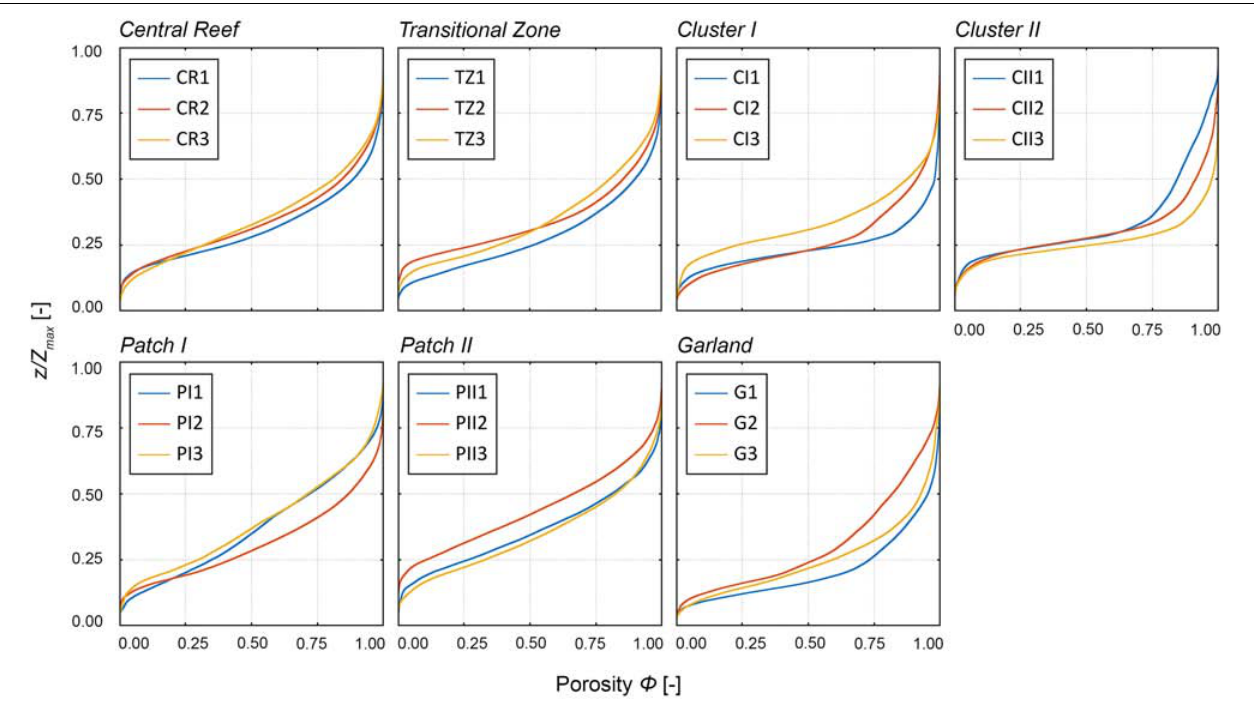
FIGURE 8 | Normalized vertical distribution of the porosity (cid:56) [-] of all samples distinguished by their structural classes over the dimensionless height z/Z max [-]. z is the surface level and Z max is the total height of surface level elevations. Top row: homogenous structural classes; Bottom row: enclosed structural classes. The colors indicate the individual samples as presented in Figure 5 , e.g., blue: CR1, orange: CR2, yellow: CR3,